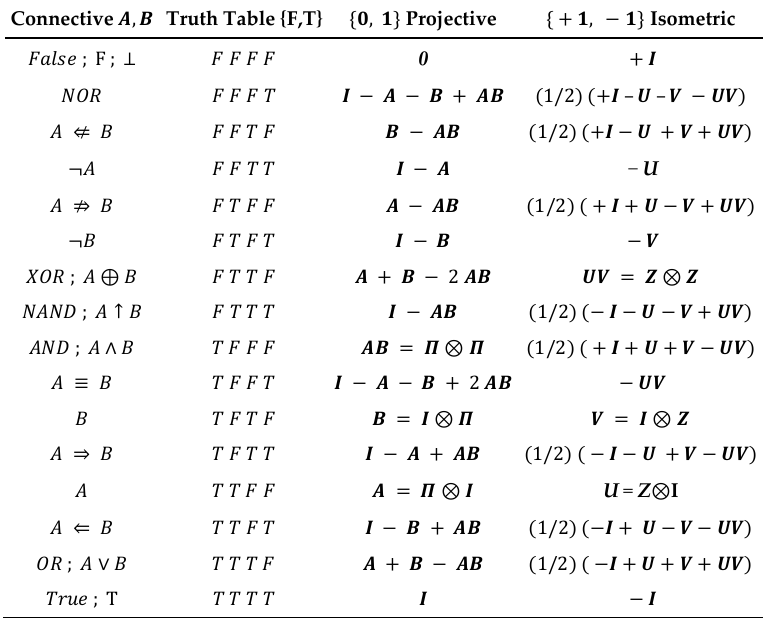
Table 1. The sixteen two-argument logical observables and their